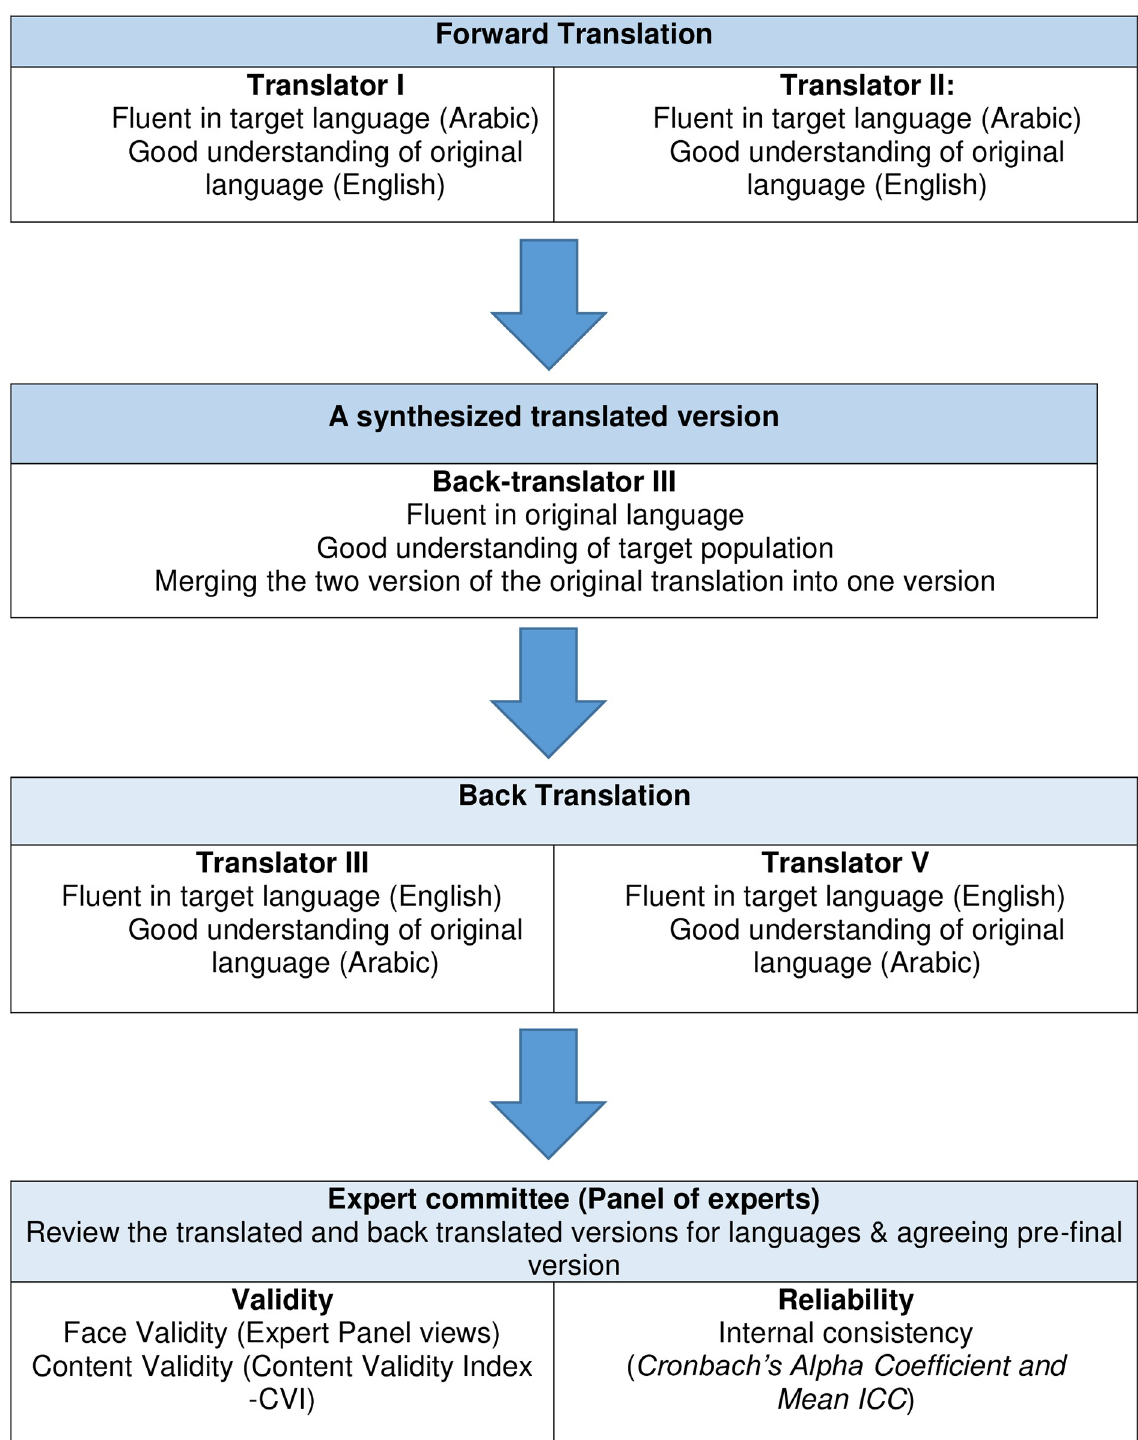
Fig 1. Translation framework (Beaton et al. 2000).